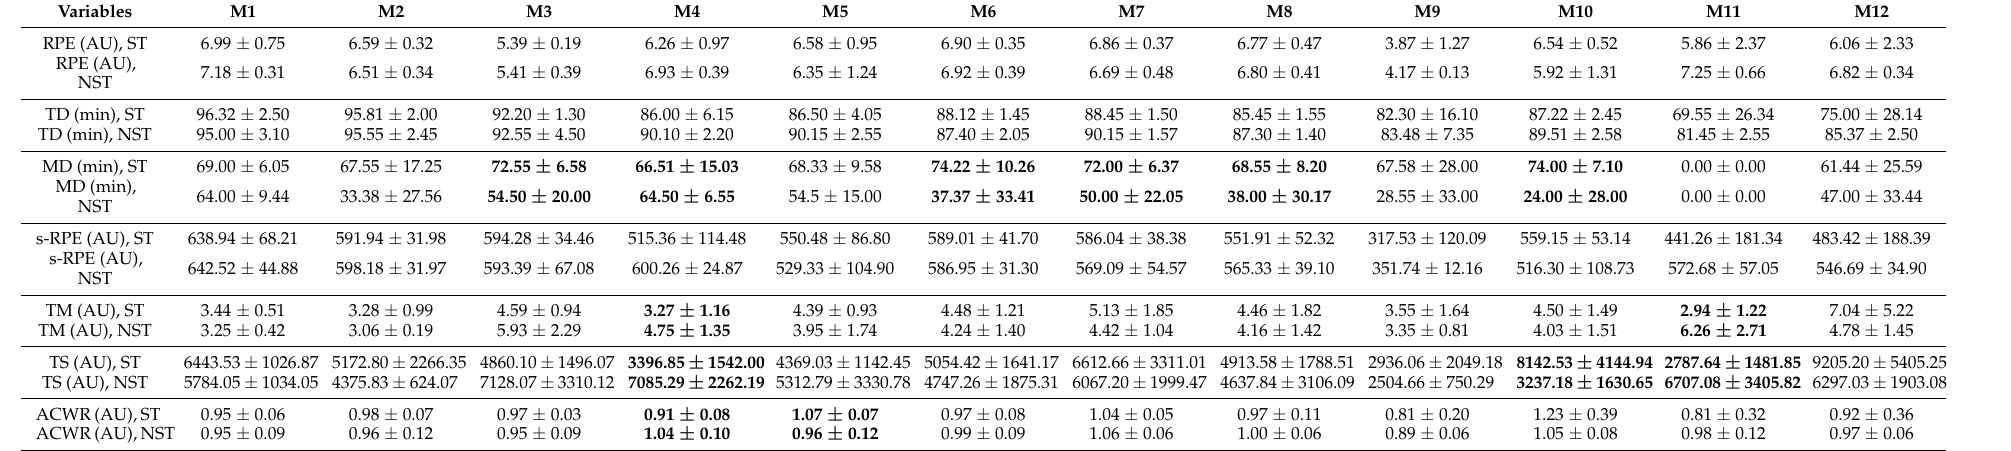
Table 3. Differences between starters and non-starters during the 12 mesocycles, Mean ±